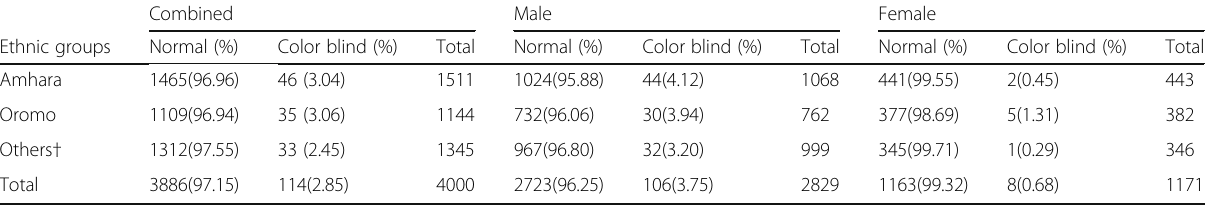
Table 1 The prevalence of congenital colour vision deficiency (CCVD) by gender and ethnic groups, Hawassa University, Ethiopia Combined Male Female Ethnic groups